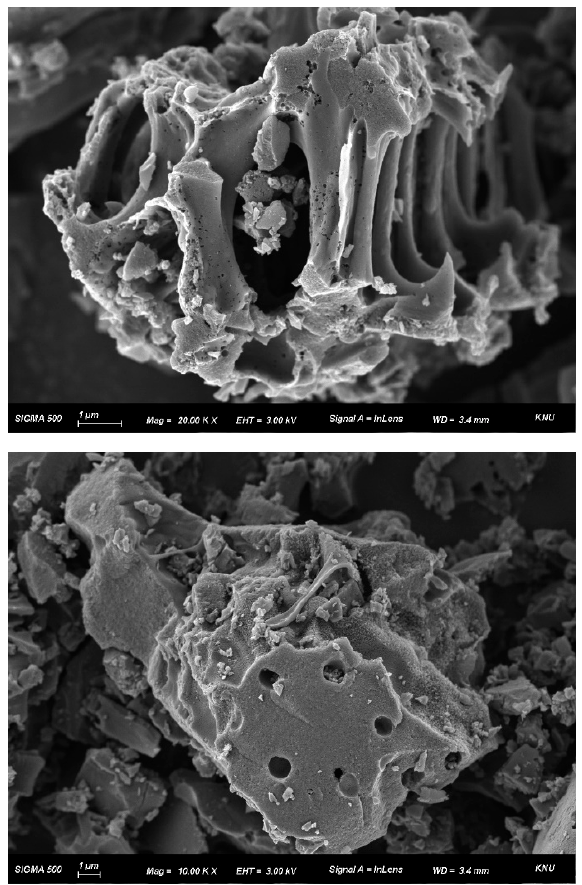
Figure 1. SEM image of palm-based activated carbon.